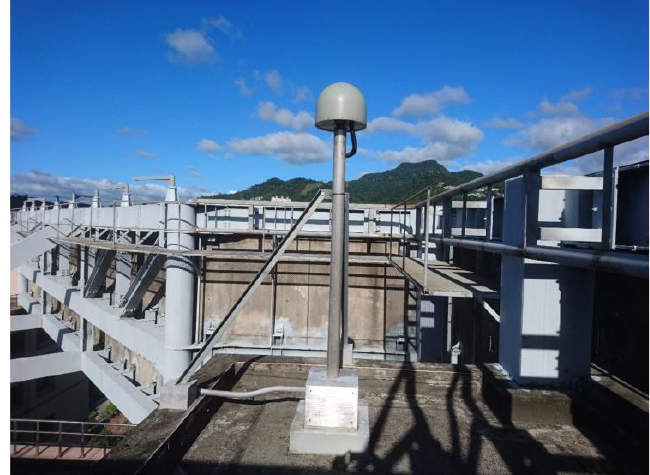
8 of 24 Figure 1. GNSS semi-generated measurements for satellite s 1 and receiver r.